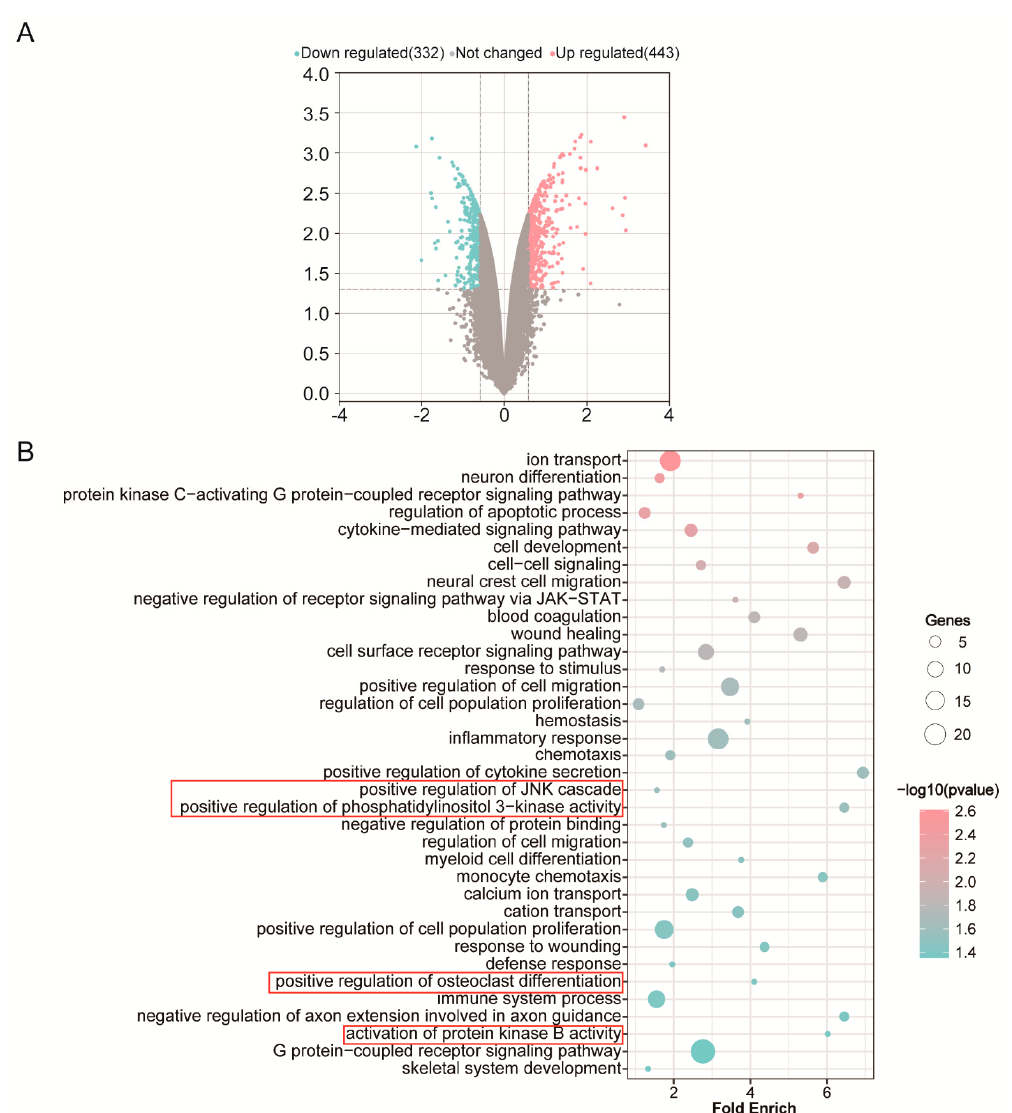
Figure 1. ( A ) Volcano plots showing the identified up-regulated (pink dots) and down-regulated (green dots) genes by IL-4 application. ( B ) Downregulated Gene Ontology (GO) terms in biological processes by IL-4 addition.